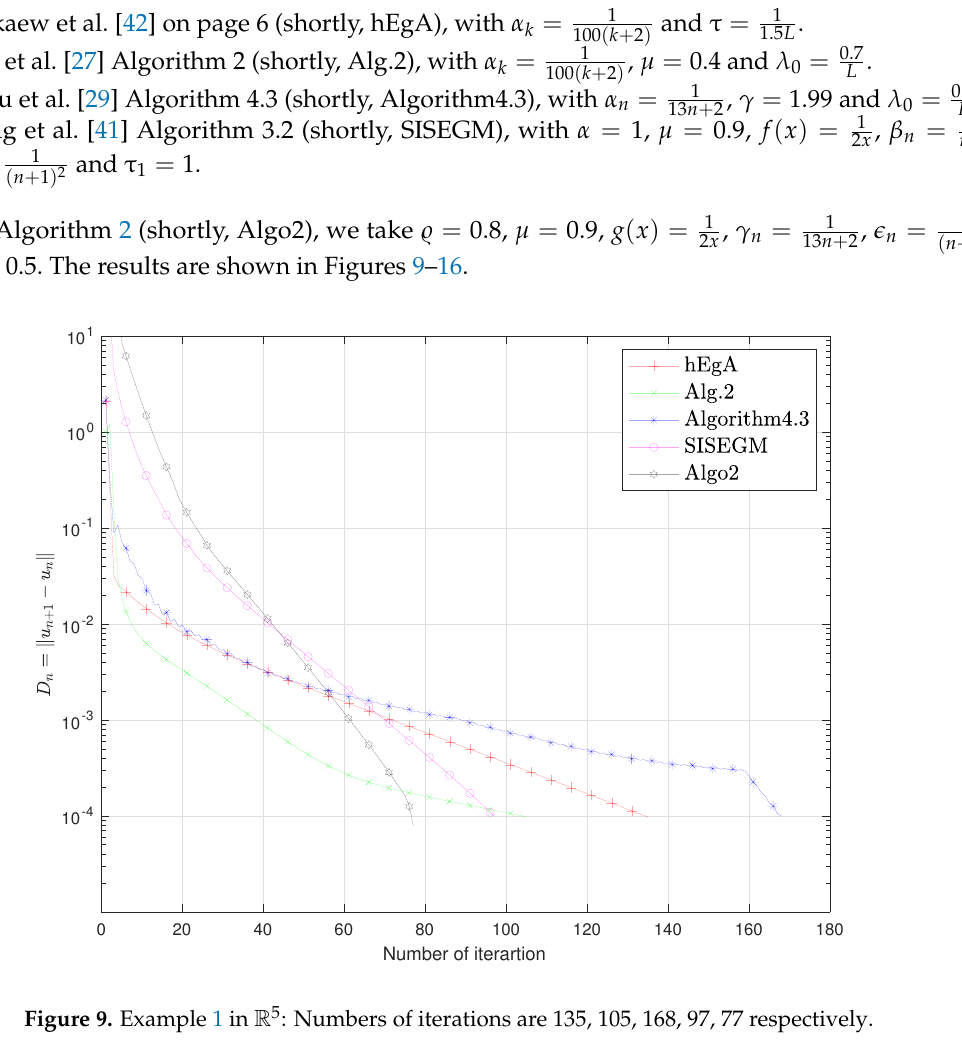
Figure 9. Example 1 in R 5 : Numbers of iterations are 135, 105, 168, 97, 77